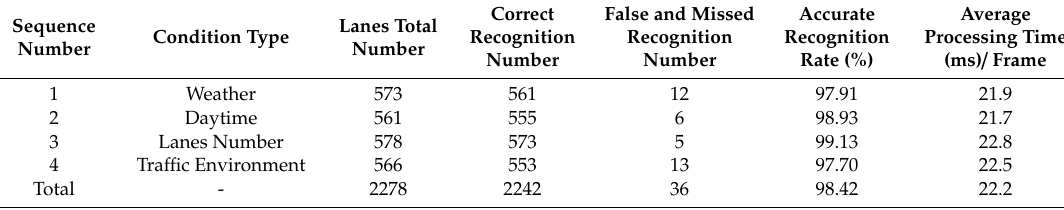
Table 2. The lane detection results under di ff erent conditions in the Tusimple